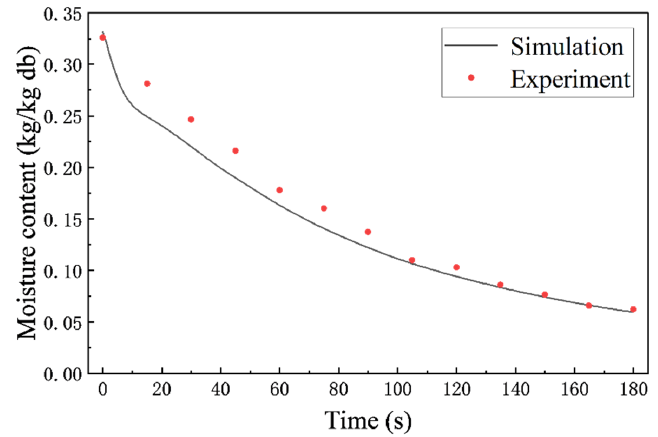
Figure 3. The average dry basis moisture content comparison between experiment and